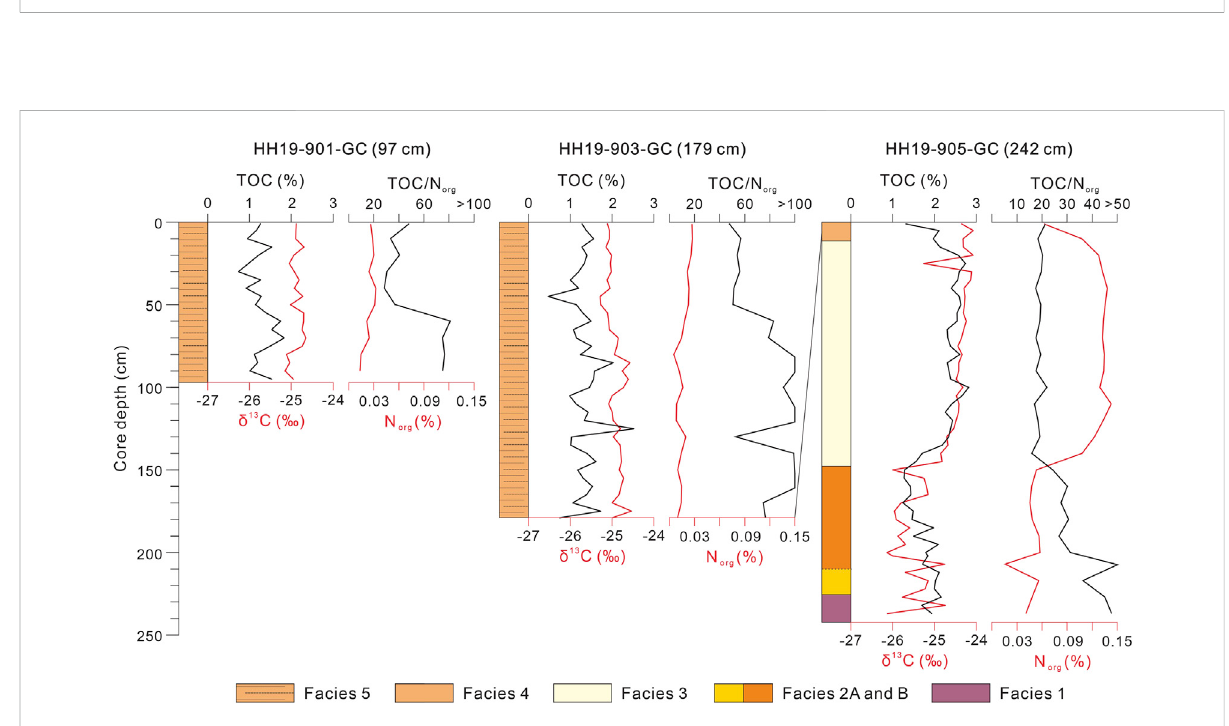
FIGURE 9 Downcore distribution of organic carbon isotope values ( δ 13 C), TOC, TOC/N org , and N org .